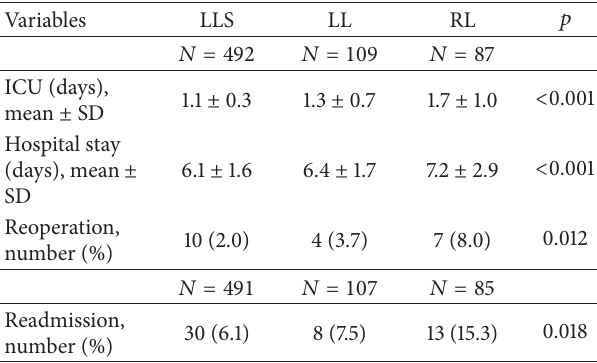
Table 5: Outcomes according to the type of liver